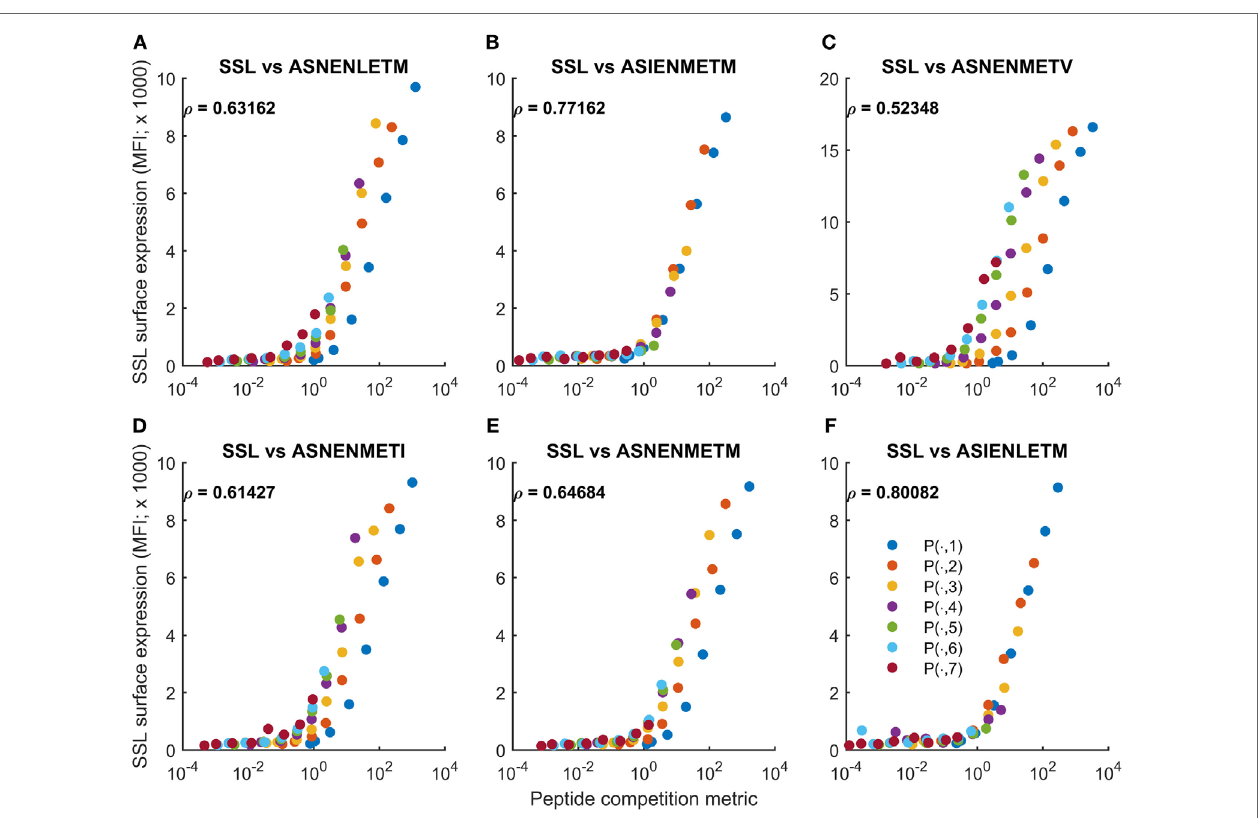
FigUre 5 | Cell surface abundance can be predicted by a peptide competition metric. The peptide competition metric F ratio (Eq. 3) was calculated using measurements of cytoplasmic peptide abundance for SSLENFRAYV and variants of ASNENMETM (fluorescence units in Figures 1 and 3 ). F ratio (horizontal axis) was then compared with experimental measurements of cell surface abundance of SSLENFRAYV (vertical axis). Different colored traces represent different cytoplasmic levels of the competing ASNENMETM variant, as indicated in Figure 1b . A to F represent competitions between SSLENFRAYV and ASNENLETM (a) , ASIENMETM (b) , ASNENMETV (c) , ASNENMETI (D) , ASNENMETM (e) and ASIENLETM (F)